Question: Write a single sentence explaining what this figure depicts.
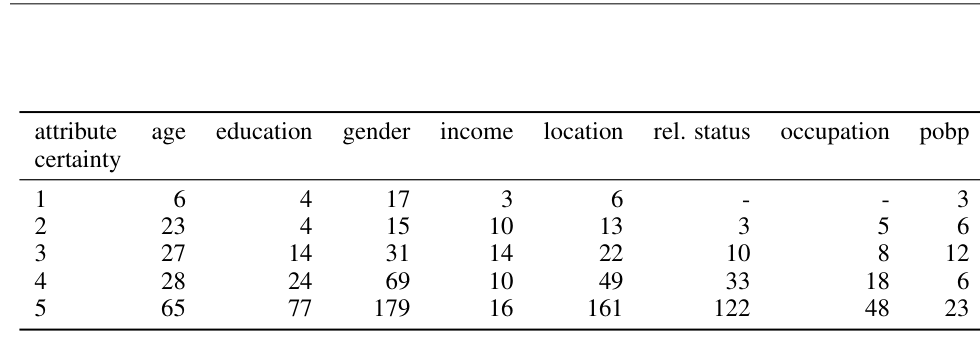
Answer: Certainty distribution of each attribute in the PersonalReddit dataset.